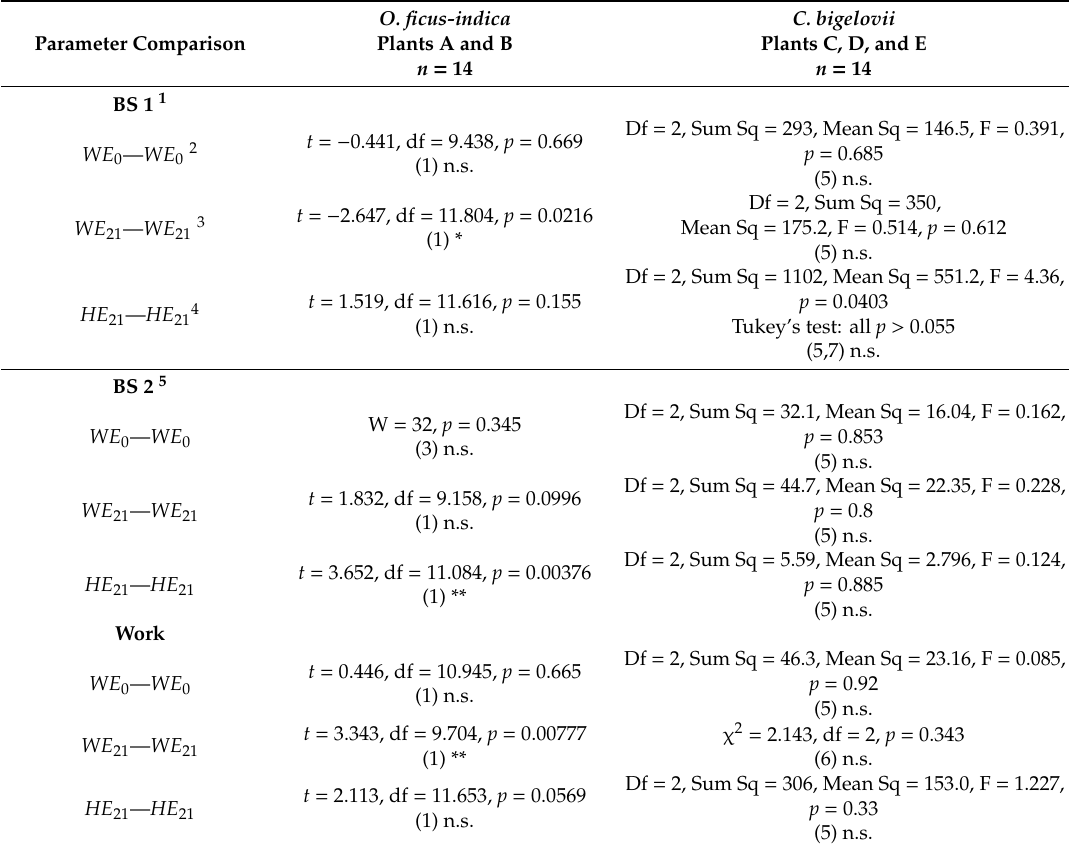
Table A1. Statistics of mechanical parameters comparing the individual plants of the plant species O. ficus-indica and C. bigelovii